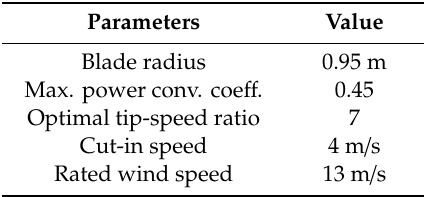
Table A1. Parameters of turbine blade model.